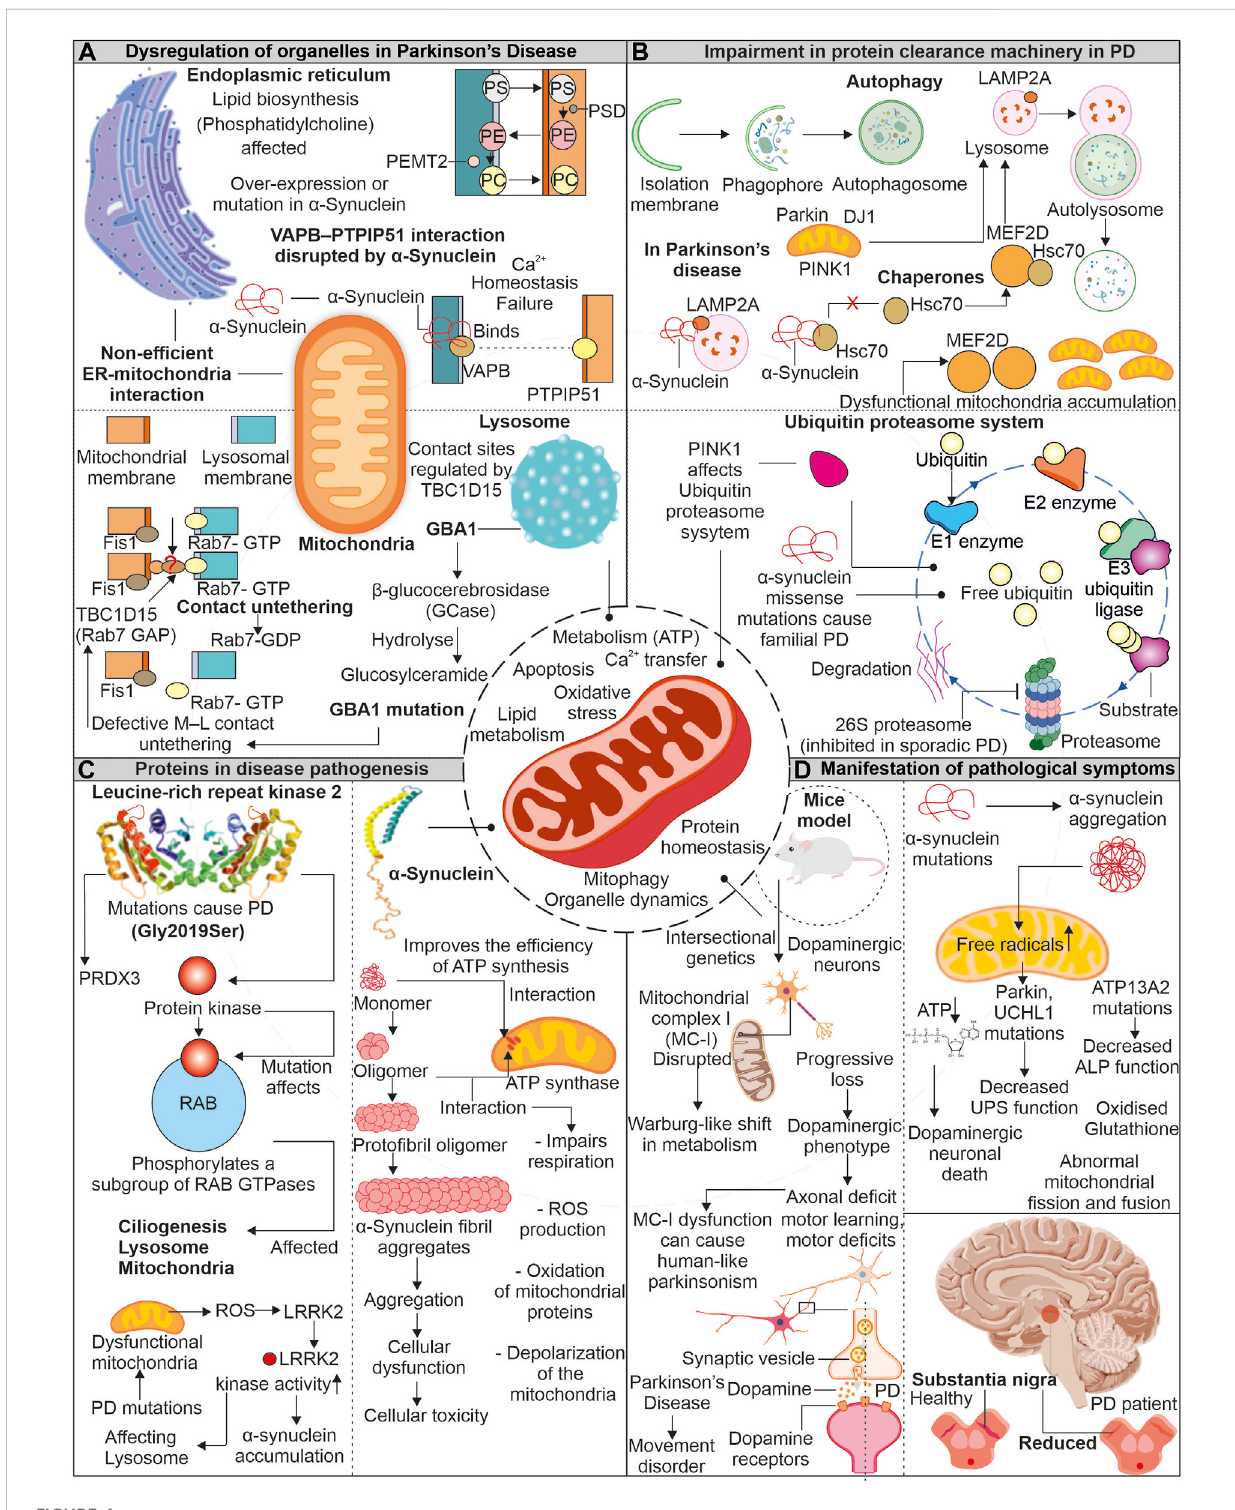
FIGURE 4 Mitochondrial impairment in Parkinson ’ s disease: Unraveling the connection. In the pathogenesis of the disease, mitochondria show dysfunctionality which affects other organelles functioning. Enzymes of lysosome like GBA1 is impaired due to mutation in PD, which affects the association of lysosome with mitochondria. Similarly, α -synuclein protein interferes with ER and mitochondrial association (A) . The impaired proteins involved in disease pathogenesis interact with autophagy and the UPS and interfere with the clearance of dysfunctional mitochondria (B) . Two proteins LRRK2 and α -synuclein, are reportedly intricate in disease pathogenesis. These proteins impair the functionality of mitochondria and increase oxidative stress (C) . Due to dysfunctional mitochondria, the dopamine-producing neurons are affected and later affect the brain region (D)